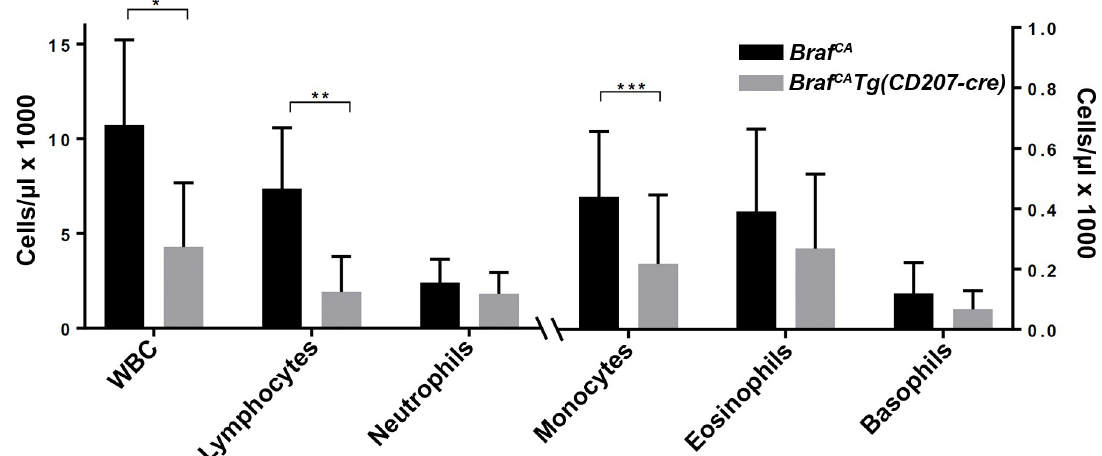
Fig 3. Peripheral blood counts in Braf CA Tg(CD207-cre) mice. Total white blood count (WBC) and differential count in Braf CA and Braf CA Tg(CD207-cre) mice aged 20 to 39 days. WBC, lymphocyte, and neutrophil counts are shown on the left ordinate; monocyte, eosinophil, and basophil counts are shown on the right ordinate. Results are shown as the mean and standard deviation of 19 Braf CA and 13 Braf CA Tg(CD207-cre) mice. Comparisons made by two-sided Welch t-test: � , p = 7.27 x 10 − 5 ; �� , p = 1.45 x 10 − 6 ; ��� , p = 0.0113.